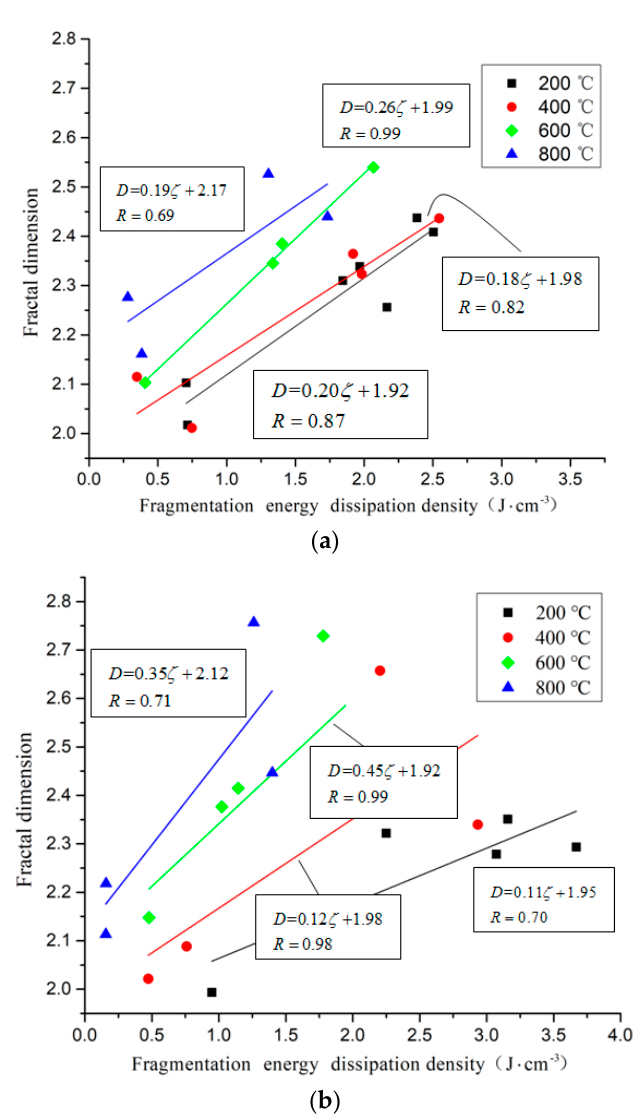
Figure 18. The linear relationship between fragmentation energy dissipation density and fractal dimension under different conditions. ( a ) Rapid heating and natural cooling ( b ) Slow heating and water cooling.